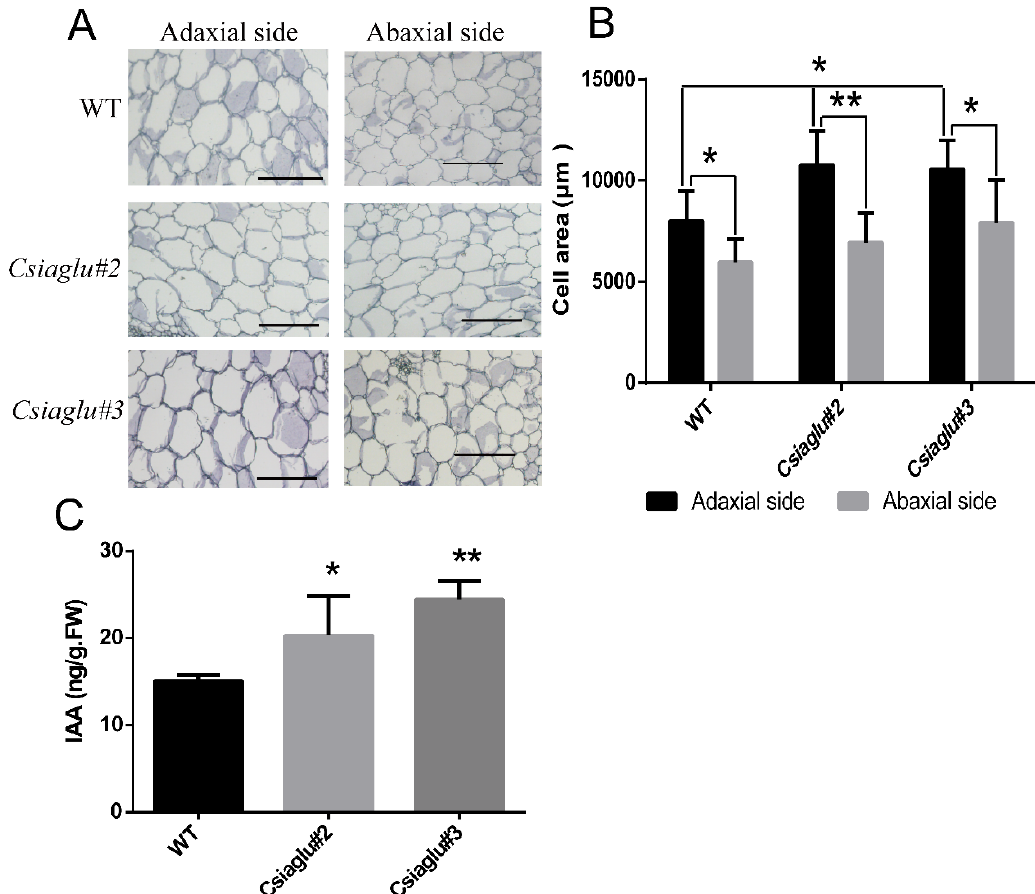
Figure 4. Cell size and auxin measurement in WT and Csiaglu mutant plants: ( A ) Cell morphology of transverse sections of petiole base in WT and Csiaglu mutants. Scale bar = 100 µ m. ( B ) Cell area statistics in WT and Csiaglu mutants. ( C ) IAA contents at the petiole base. A significance analysis was conducted with the two-tailed Student’s t -test (* p < 0.05 and ** p < 0.01). Values are means ± SDs ( n = 9 in ( B) ; n = 3 in ( C )).